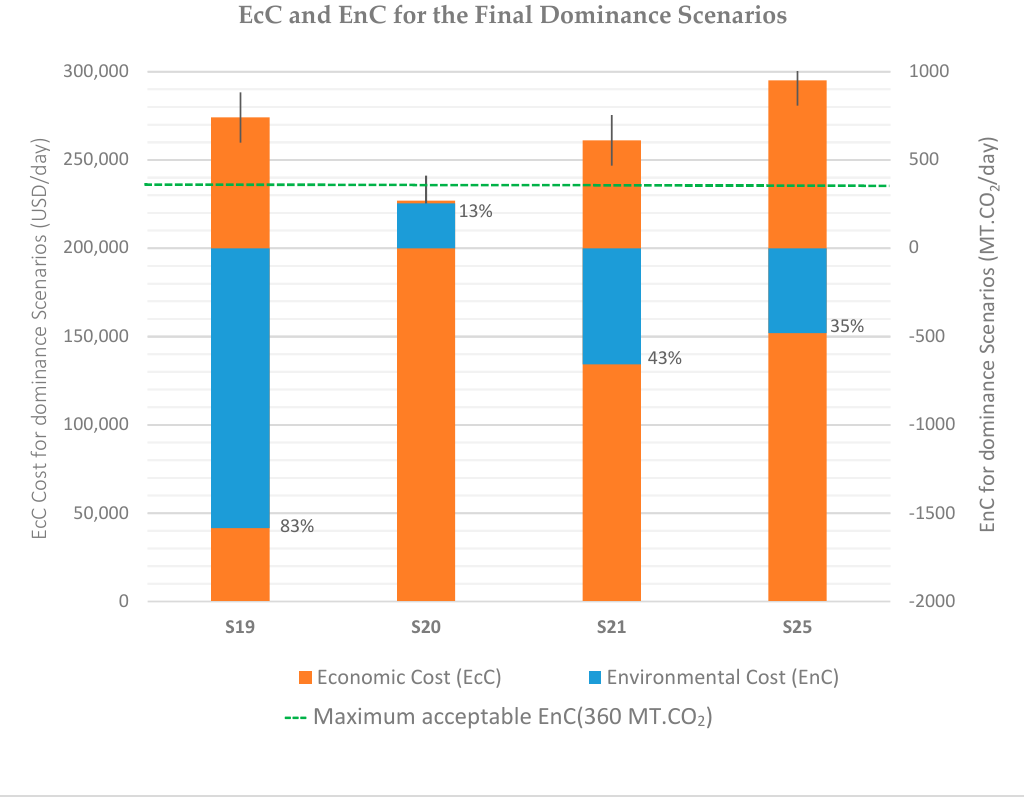
Figure4. Figure 4. The Elimination and Choice Expressing Reality (ELECTRE) aggregates of dominance scenarios.